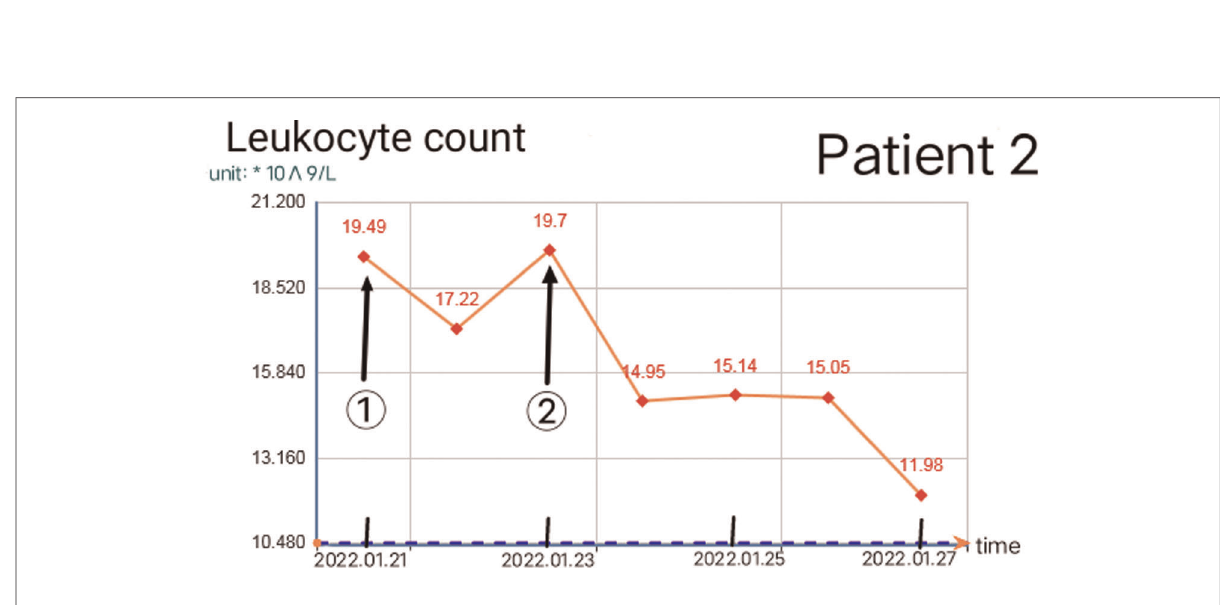
FIGURE 9 Change of leukocyte count in patient 2 ( ① and ② are the debridement time of the fi rst and second operation